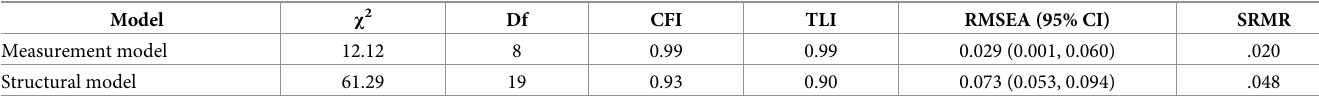
Table 4. Comparison of goodness-of-fit indices across models. Model